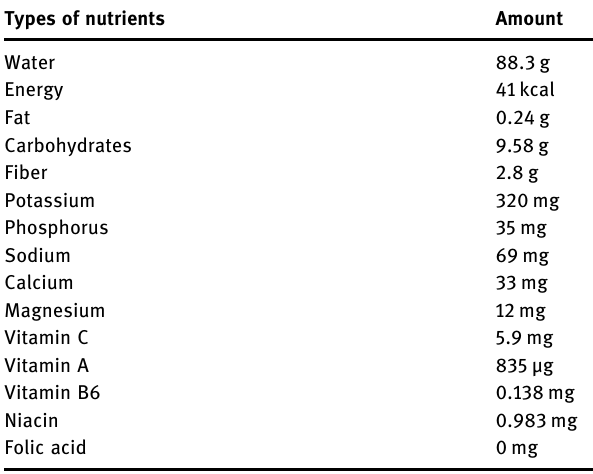
Table 1: The nutritional content of carrots per 100 g Types of